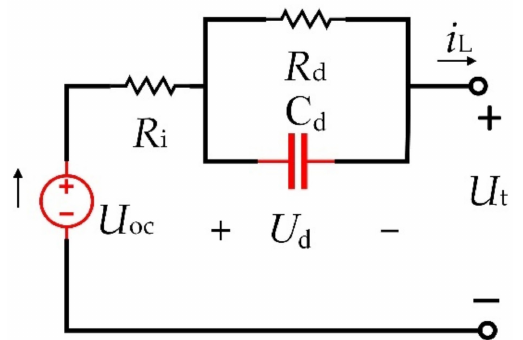
Figure 1. The schematic diagram of the Thevenin